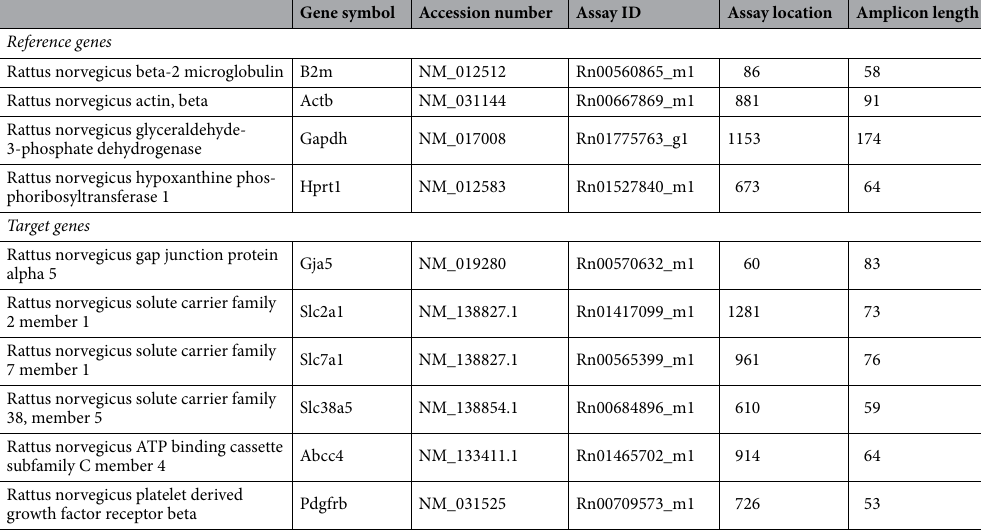
Table 1. Features of the assays used for semiquantitative real time polymerase chain reaction (qRT-PCR) for validation and conformation of microarray measurements.